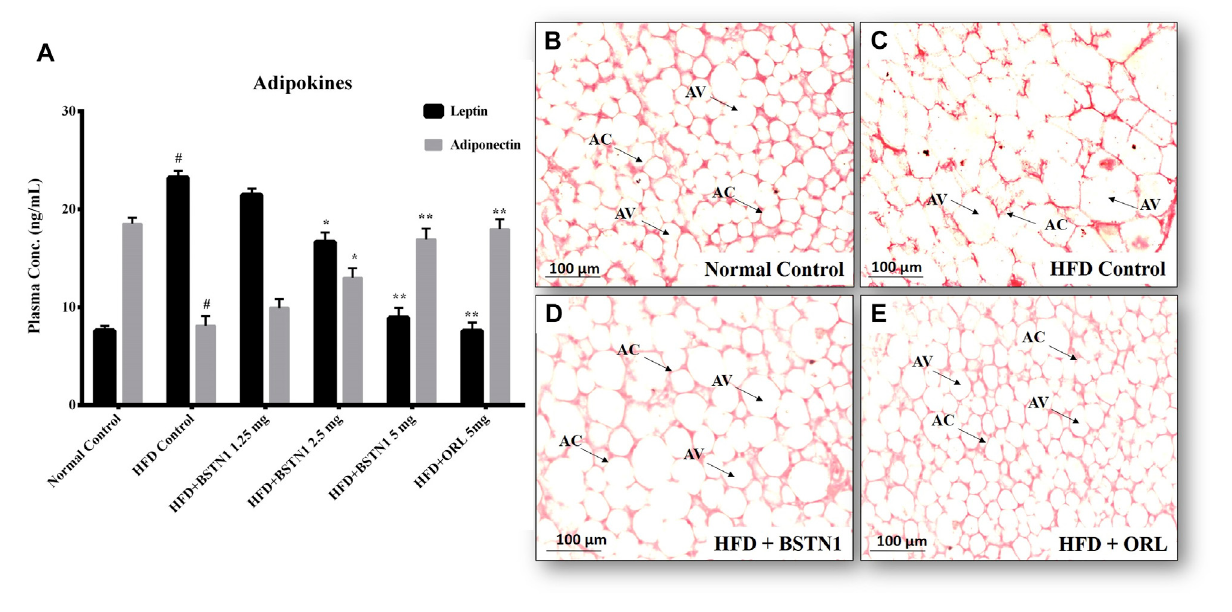
FIGURE 5 | Effect of BSTN1 on adipokines and histology of white adipose tissue (40x magni fi cation). (A) Plasma adipokines levels represented as mean ± SD, n (cid:2) 6. # denotessigni fi cant( p < 0.001)differencebetweennormalcontrolandHFDcontrol.*and**denotesigni fi cantdifferencebetweenHFDcontrolandtreatedgroups at p < 0.05and p < 0.01,respectively. (B) Histologyofnormalcontroladiposetissue (C) HFD-fedgroupshowingenlargedandlipidladenadipocytes (D) HFDfedBSTN1 treated group showing reduction in adipocytes ’ size and lipid content (E) HFD fed orlistat treated group. AC, Adipocyte Cell and AV, Adipocyte Volume. Scale bar: 100